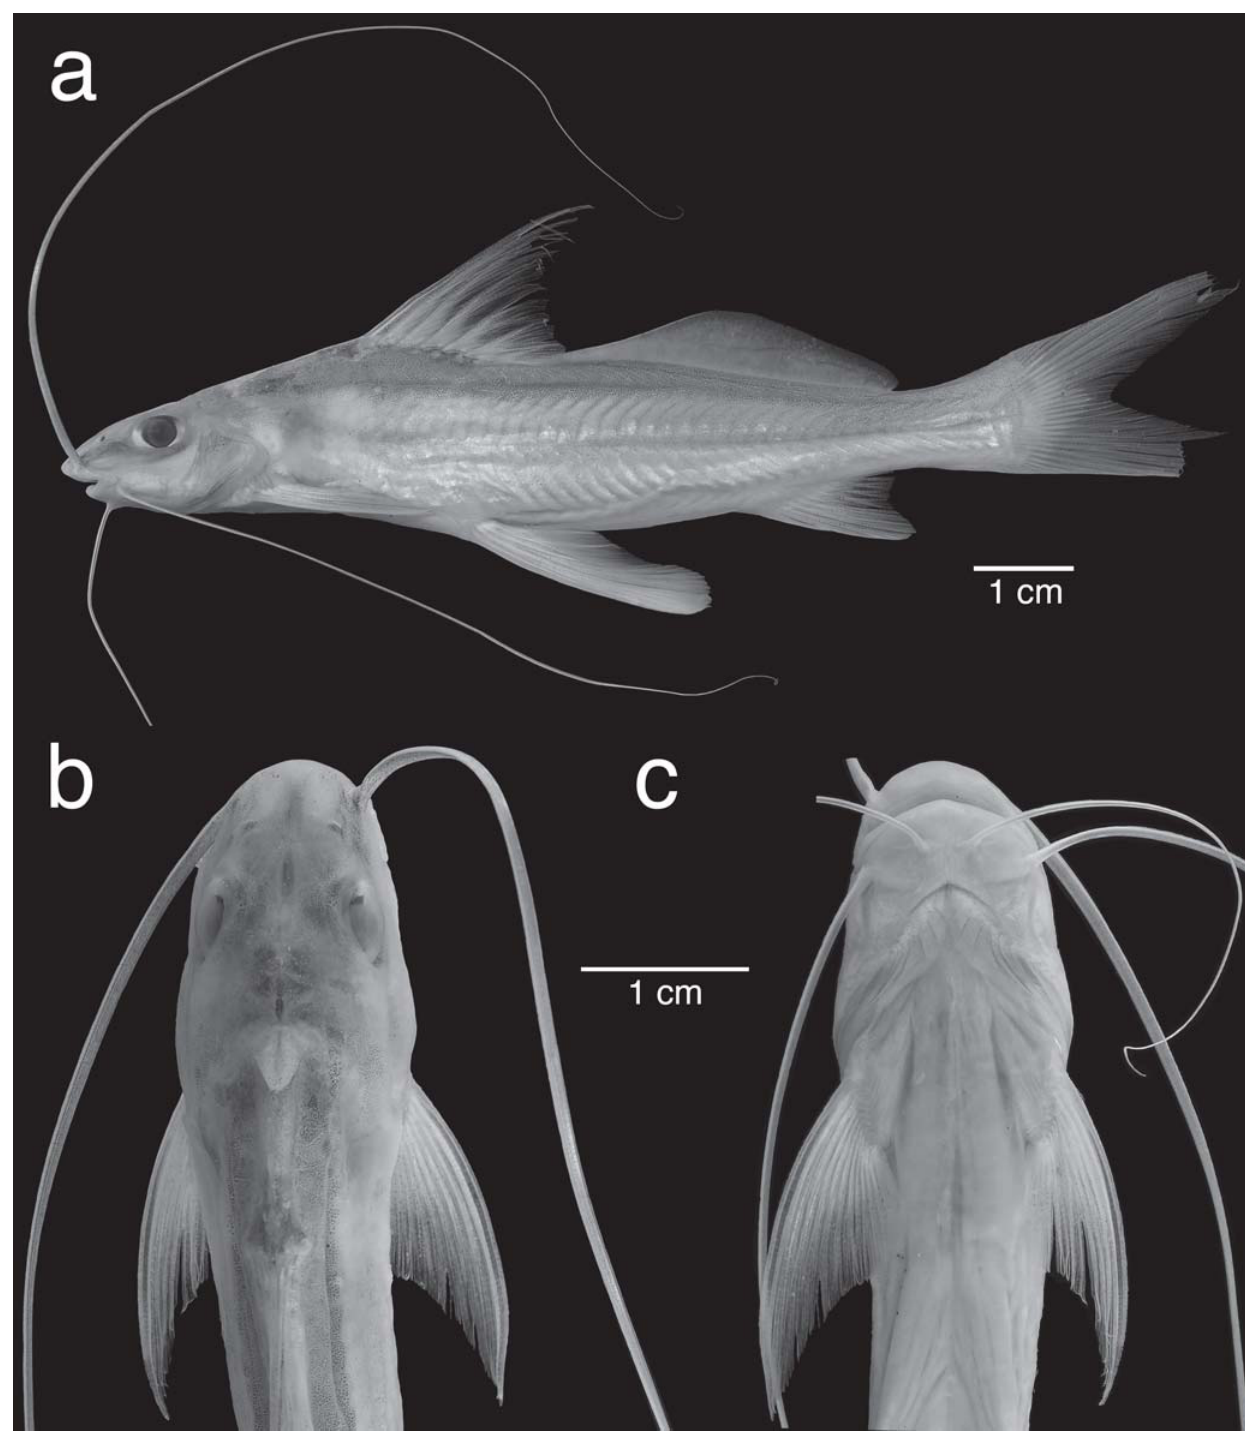
Fig. 7. Megalonema orixanthum , holotype, Colombia, Meta State, río Metica, ca. 3 km SE of Hacienda Mozambique. ANSP 187449, 100 mm SL, in a , lateral, b , dorsal and c , ventral view; distal ends of barbels clipped from image then convex onto anal-fin base, slanting dorsally to caudal peduncle and concave along caudal peduncle. ral spine insertion, contained 6.5-8.7 times in SL.